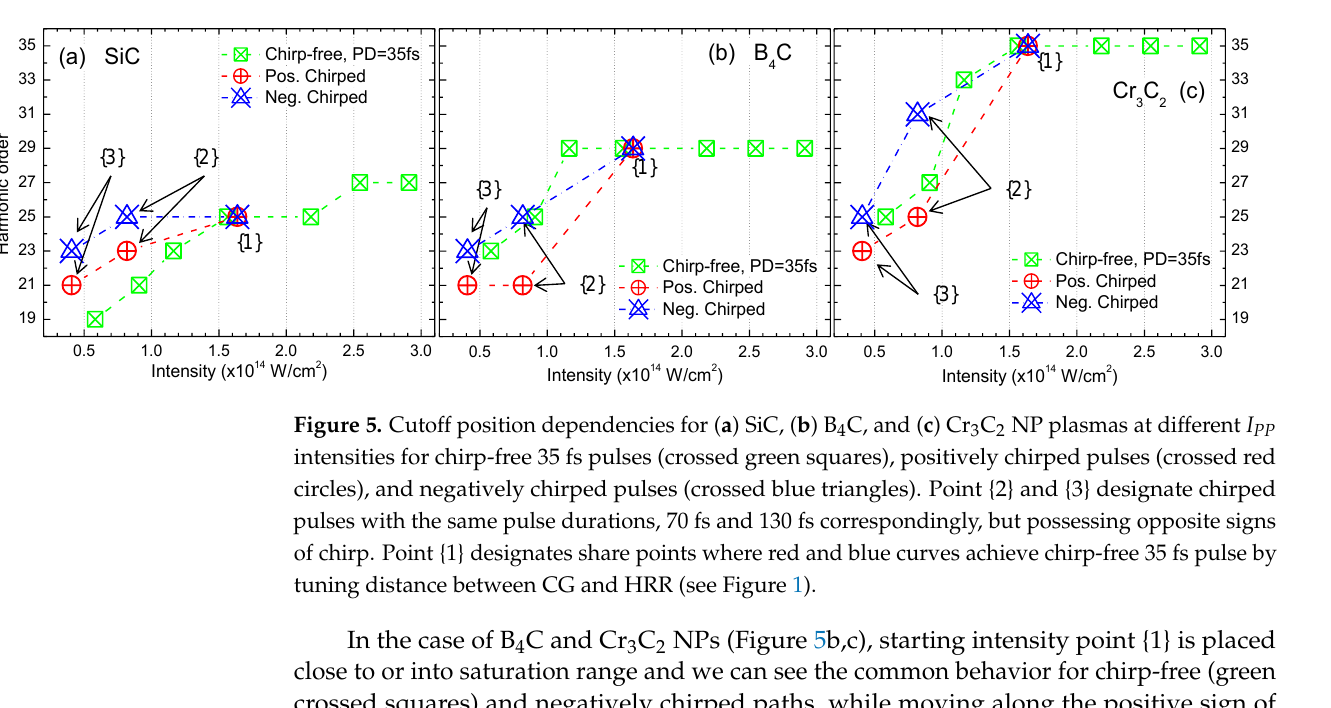
red and blue crossed symbols in Figure 5 present the dependencies of cutoff position in the case of variations of chirp. Red symbols correspond to the path of increasing positive chirp by points {1} → {3} and blue—the path of increasing negative chirp by points {1} → {3}. Point {2} and {3} designate chirped pulses with the same measured by autocorrelation technique pulse durations, 70 fs and 130 fs correspondingly, but opposite signs of chirp. Point {1} designates share points where red and blue curves achieve chirp-free 35 fs pulse by tuning a distance between CG and HRR. For all three materials, the initial point {1} is chosen I PP = 1.65 × 10 14 W/cm 2 . The pulse energy along paths {1} → {3} was not changed.